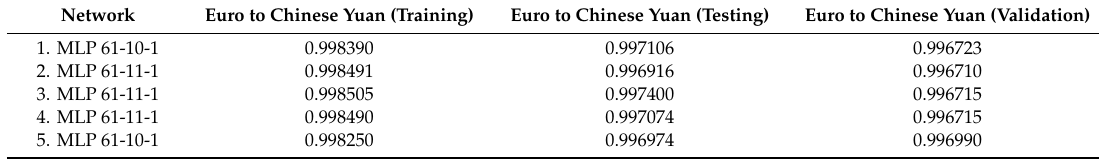
Table 7. Correlation coe ffi cients of individual data